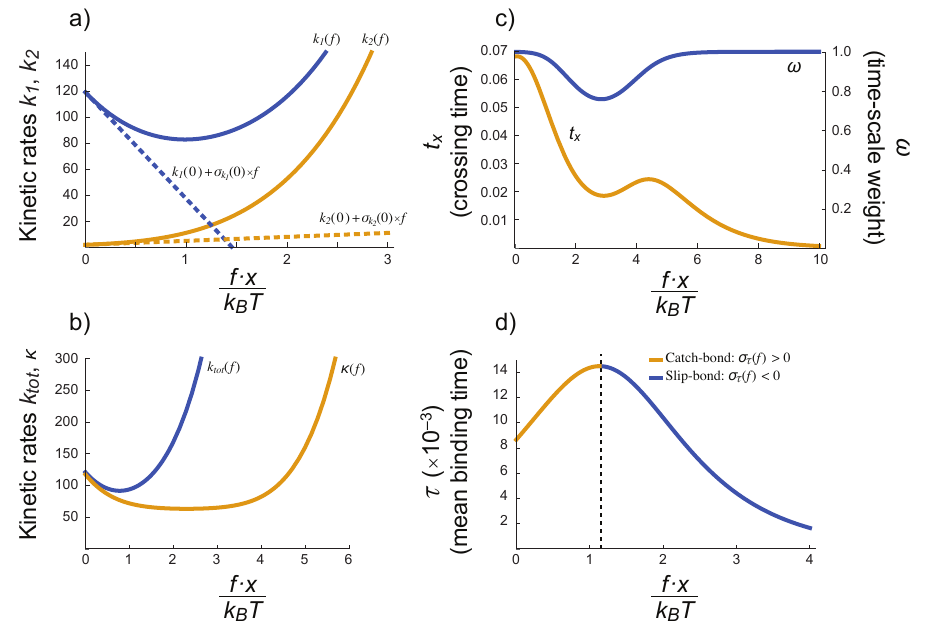
Figure 5. The BCR–Ag interaction might display a catch-bond behavior. The dependence on the force f of the main kinetic rates k 1 and k 2 (defined in Equations (19) and (20)), the rates k tot and κ (defined in Equations (22) and (23)), timescales weight ω (defined in Equation (21)), and times t x and τ (defined in Equations (27) and (31)) is introduced in those variables through the basic rates k − , k − , k + and k − defined in Equations (25) and (26). ( a ) Variation of k 1 and k 2 with the (scaled) 0 1 01 01 applied force; dashed lines are the corresponding tangent lines at f = 0 with slopes equal to the rates ( f ) affects the sign of the sensitivity sensitivities at f = 0. Note how the negative sensitivity of k − 01 of k 1 and k 2 at low forces. ( b ) Total kinetic rate, k tot and kinetic rates difference, κ . ( c ) Weight of the timescales, ω , and crossing time, t x . ( d ) Dependence of the mean bond lifetime, τ , on the (scaled) applied force. The combination of k 1 , k 2 and ω in Equation (31) and the negative sensitivity of ( f ) opens the possibility of a catch-bond behavior (the binding time increases with the applied k − 01 force, at least for low forces). These plots were obtained using the following parameter